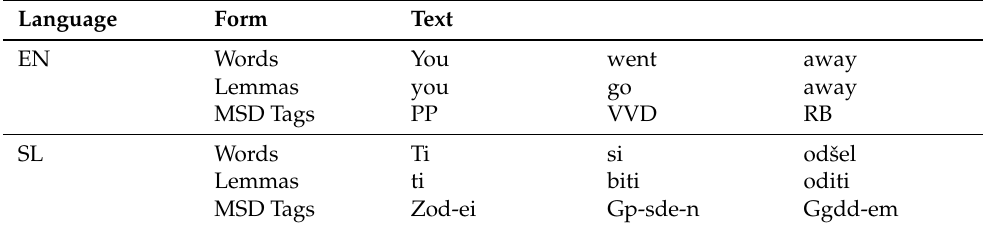
Table 3. Example of a MSD tagged and lemmatized sentence in English (EN) and Slovene (SL).